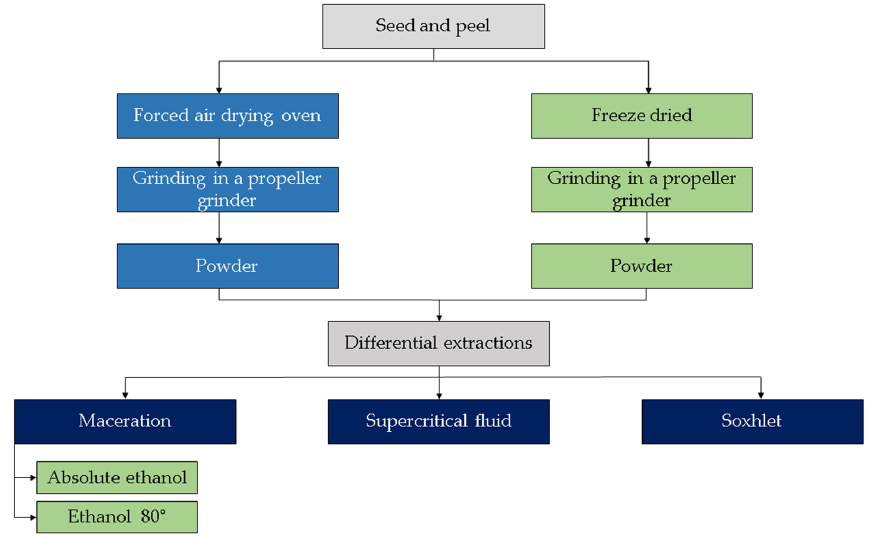
Figure 3. Scheme of the extraction procedure of phytochemicals from the seed and peel. Extracts from S. betaceum fruit peel from Alimentos SAS (Bogotá, Colombia) were also obtained by supercritical fluid extraction (SFE) and Soxhlet extraction (SE), but their chemical composition has not been described hitherto (Figure 3). The highest antioxidant activity in a trial when using cooked beef was demonstrated by the extract obtained by SFE with CO 2 /EtOH (50 °C/30 MPa and 2% EtOH) [43]. Sanchez et al. [44] reported anti ‐